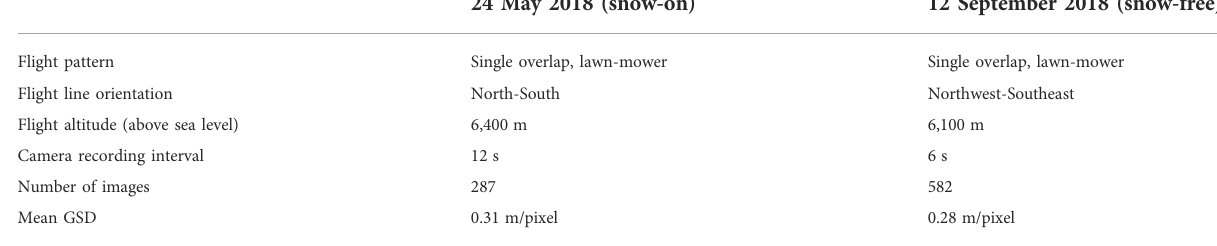
TABLE 1 Flight parameters for snow-on and snow-free